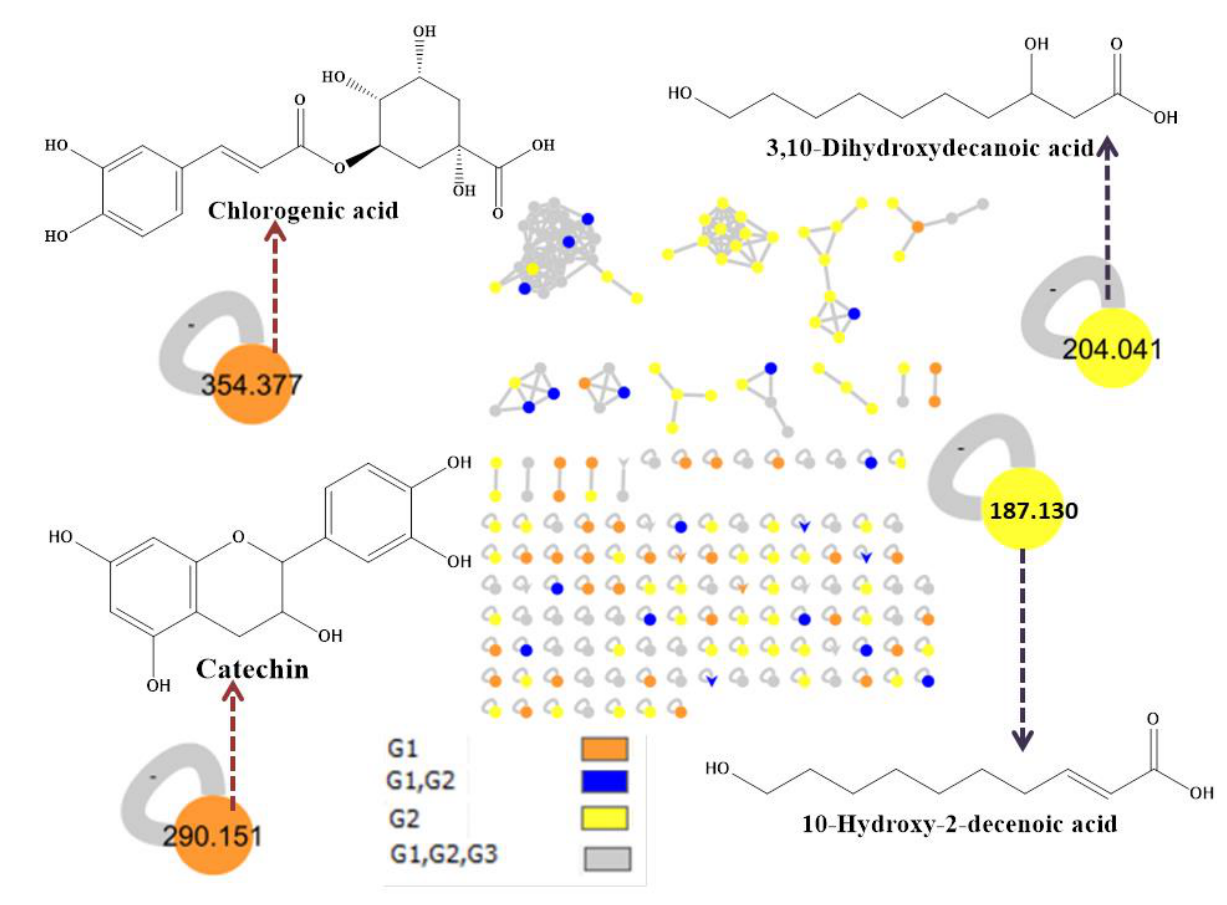
Figure 1. Identified bioactive compounds from P and RJ using LQT-MS-MS analysis and assisted Global Natural Product Social (GNPS) molecular network. The nodes refer to parent masses of the extracts metabolites. The circular nodes refer to the whole parent masses. The triangle nodes represent parent ions that have been identified in the GNPS molecular network. G1: Propolis, G2: Royal jelly, G3: blank solvent used. Table 1. Bioactive compounds identified from Prolis and Royal jelly using LTQ-UPLC-MS-MS analysis.